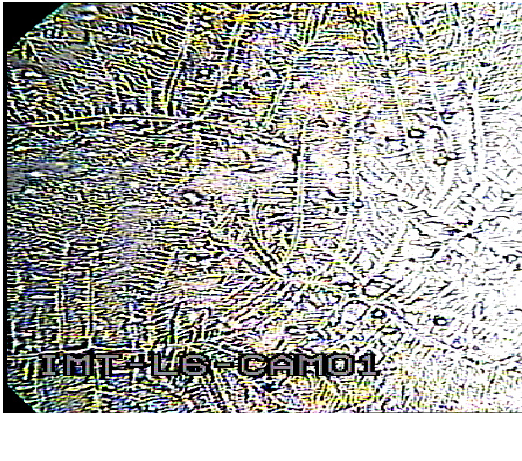
Figure 15. Picture of HACAT cell culture in the mini-incubator after 50 h of culture (×100